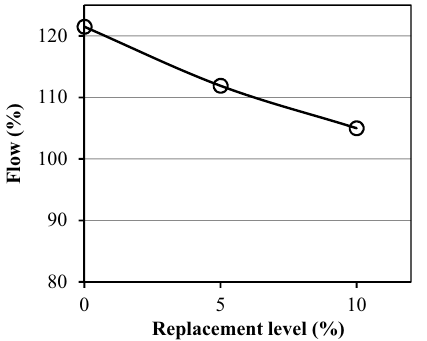
Figure 11: Flexural strength of